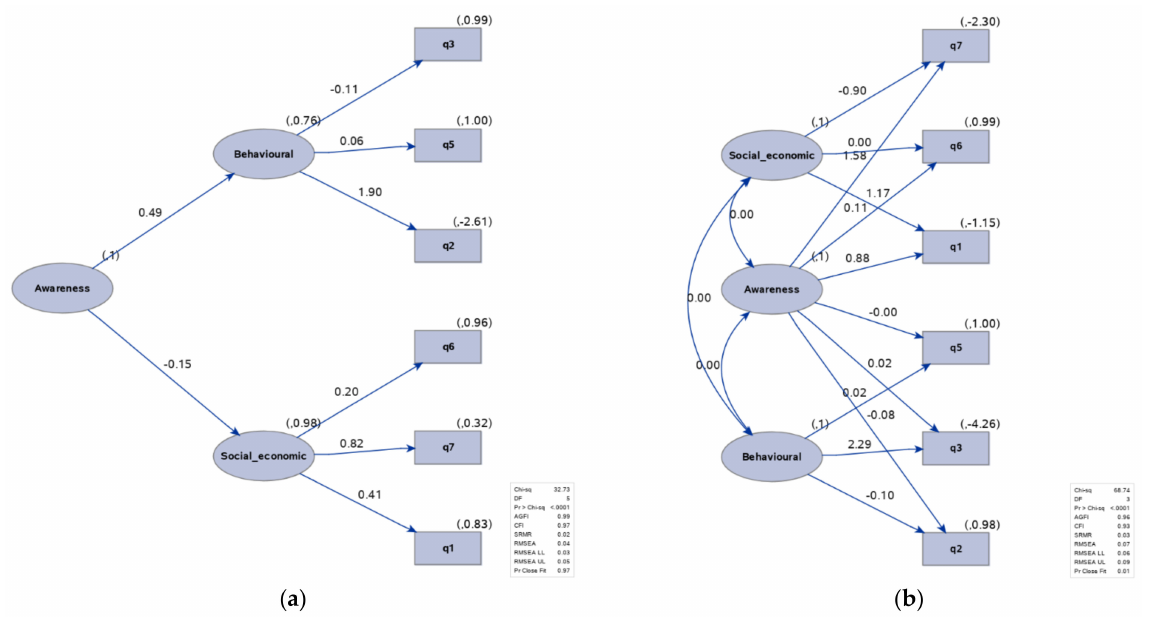
Figure 10. Path diagrams for the pre-trial questionnaire data set ( a ) second-order, ( b ) bi-factor.